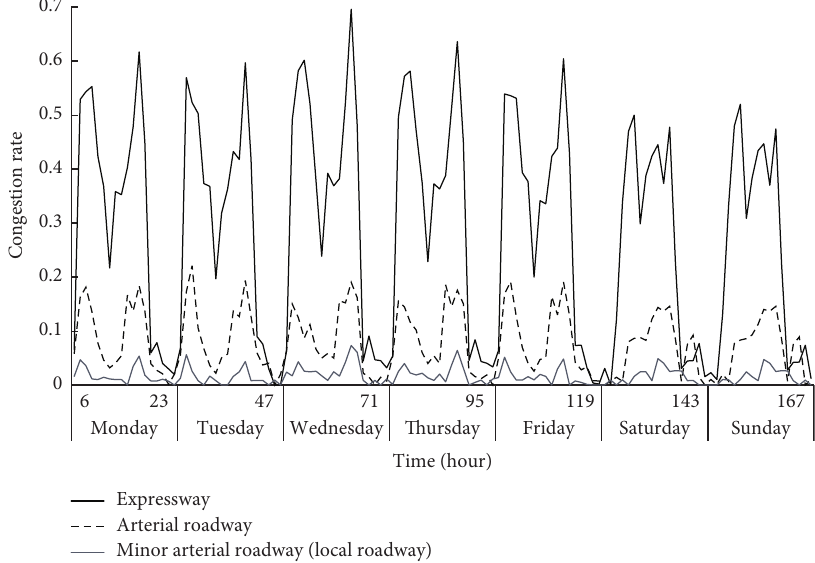
Figure 8: Changing curve of traffic congestion ratio of each grad of roadway during a